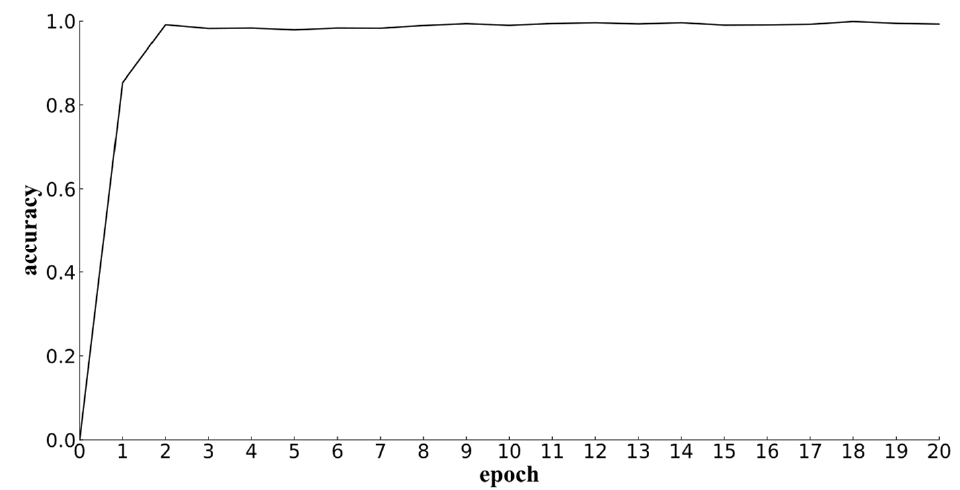
Figure 14. Accuracy graph.